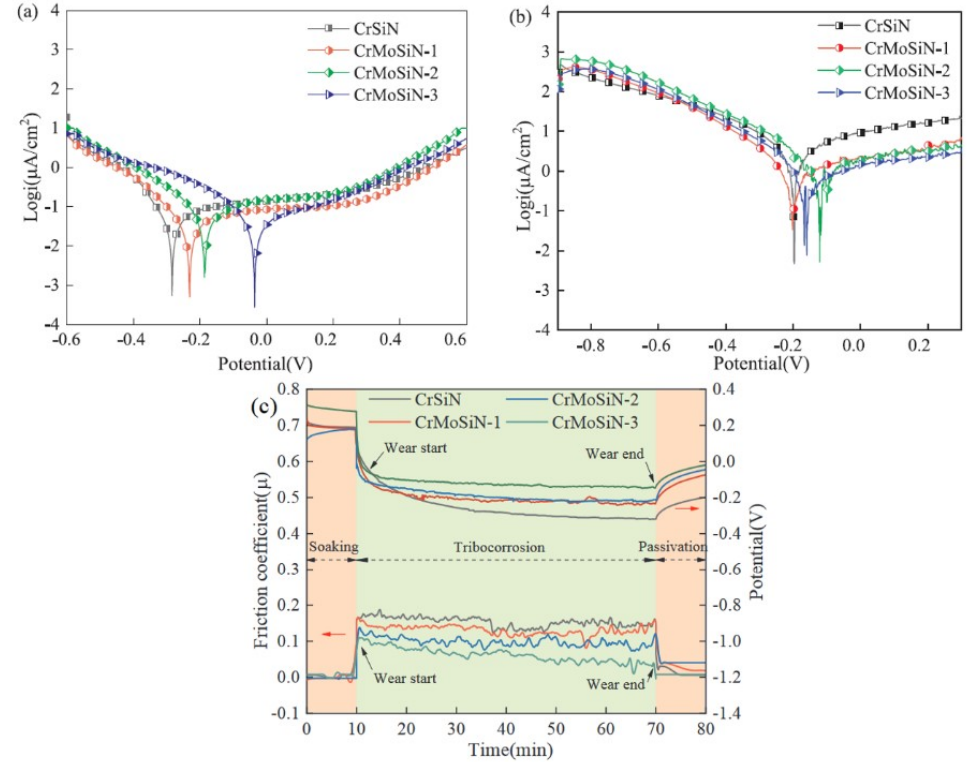
Figure 1. Potentiodynamic polarization test results under ( a ) static corrosion, ( b ) tribocorrosion. ( c ) Tribocorrosion under OCP. (Reprinted from Applied Surface Science, 525, Y. Fu, F. Zhou, M. Zhang, Q. Wang, and Z. Zhou, Structural, mechanical and tribocorrosion performances of CrMoSiN coatings with various Mo contents in artificial seawater, 146629, Copyright (2020), with permission from